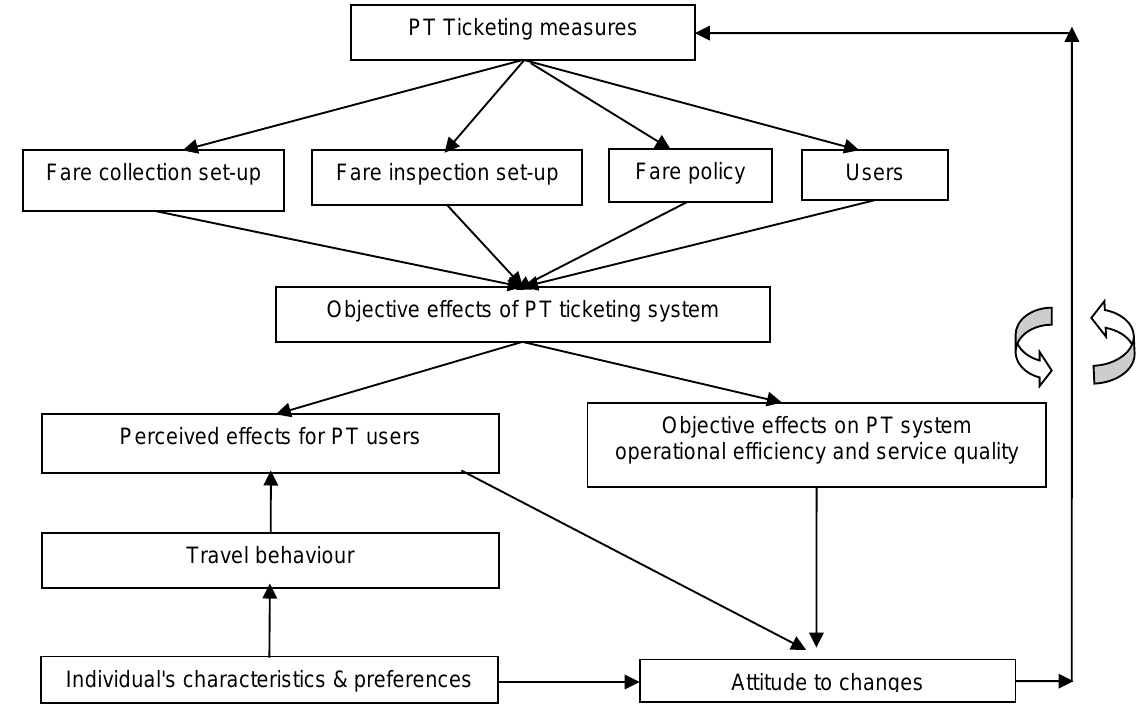
Figure 4. A conceptual framework for factors affecting attitudes towards